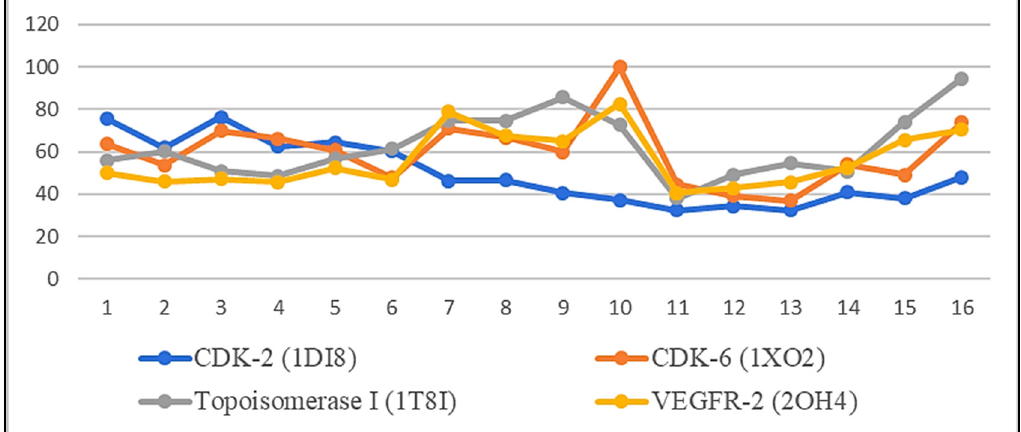
Figure 8. The relative percentage of the binding affinity of each isolated compound toward the four oncogenic targets.